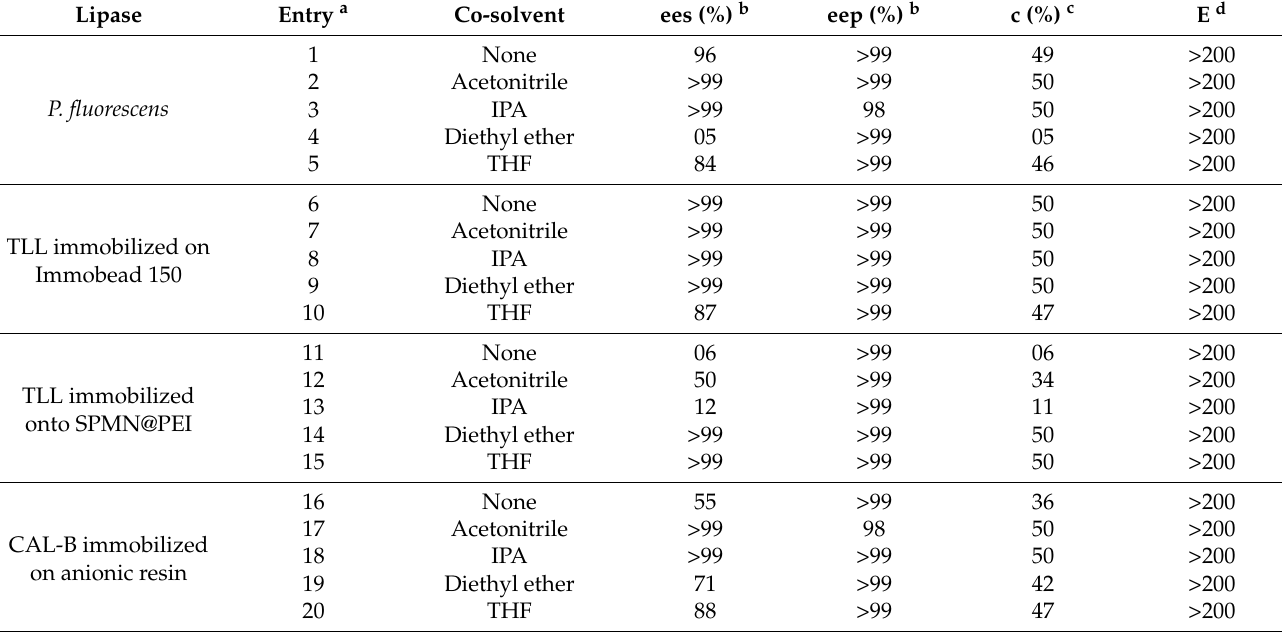
Table 2. Influence of the co-solvent on the KR of rac - 5a , via hydrolytic approach, catalyzed by lipases.